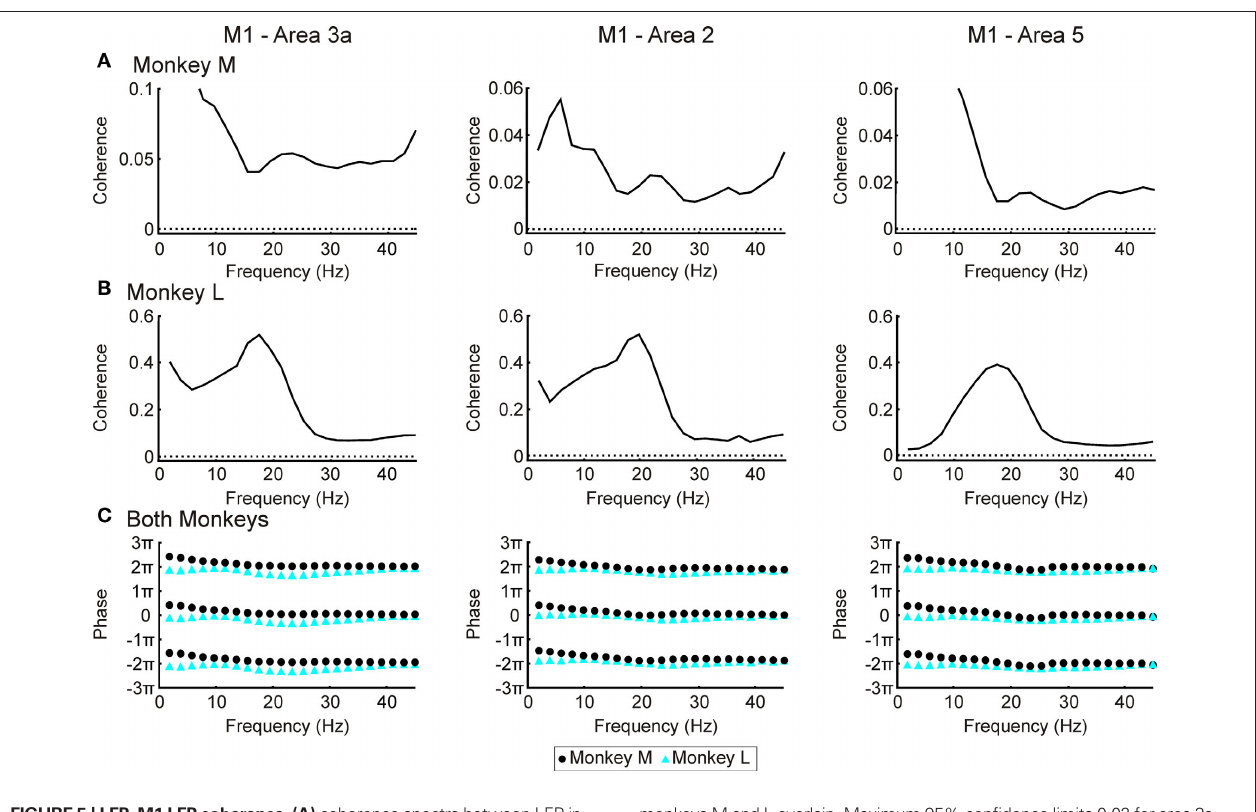
Figure 5 | LFP–M1 LFP coherence. (A) coherence spectra between LFP in areas 3a, 2 and 5 and M1 for monkey M. (B) as (A) but for monkey L. Dotted lines represent P < 0.05 significance levels. (C) Phase spectra with results from